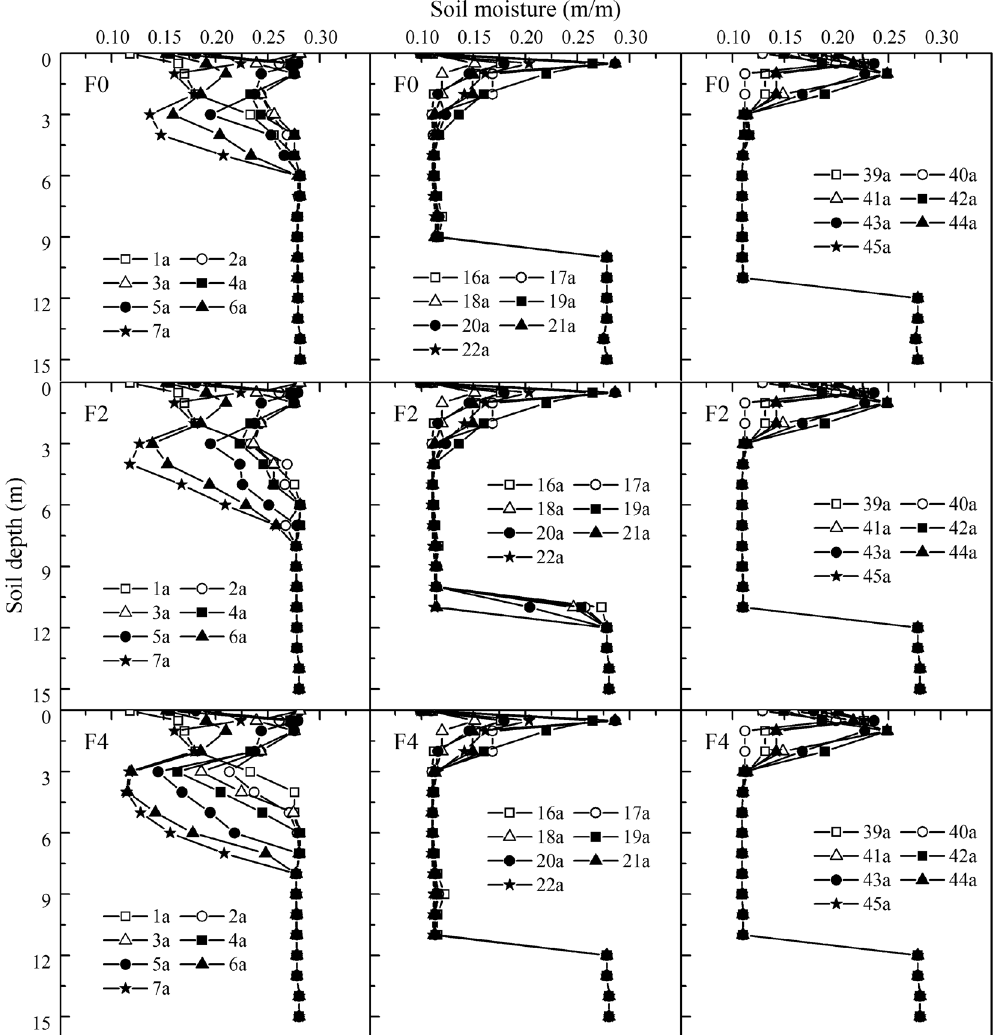
Figure 4. Simulated annual soil moisture profiles in the 0–15 m soil layer under different fertilization treatments in the apple orchards of Luochuan.